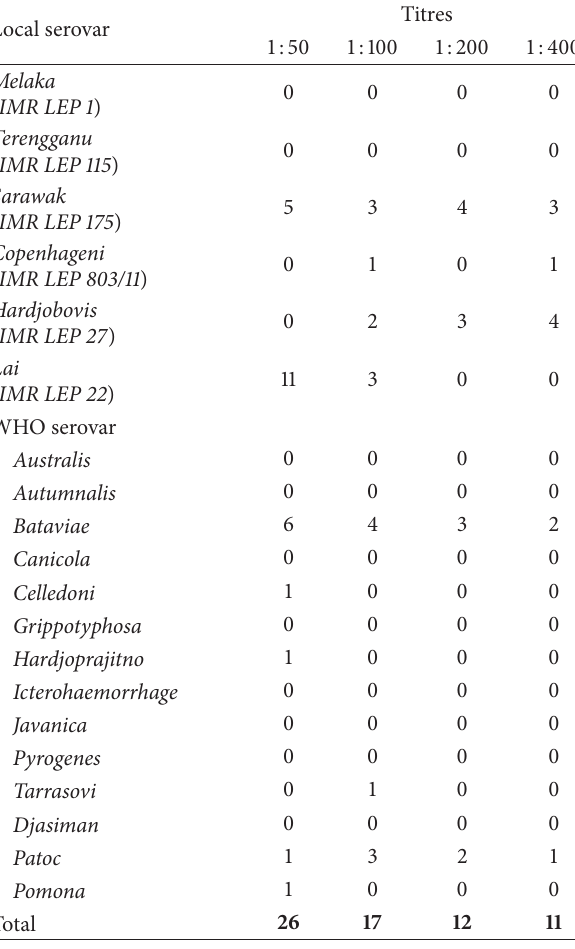
Table 4: Leptospiral antibody titres of local and WHO serovars. Local serovar